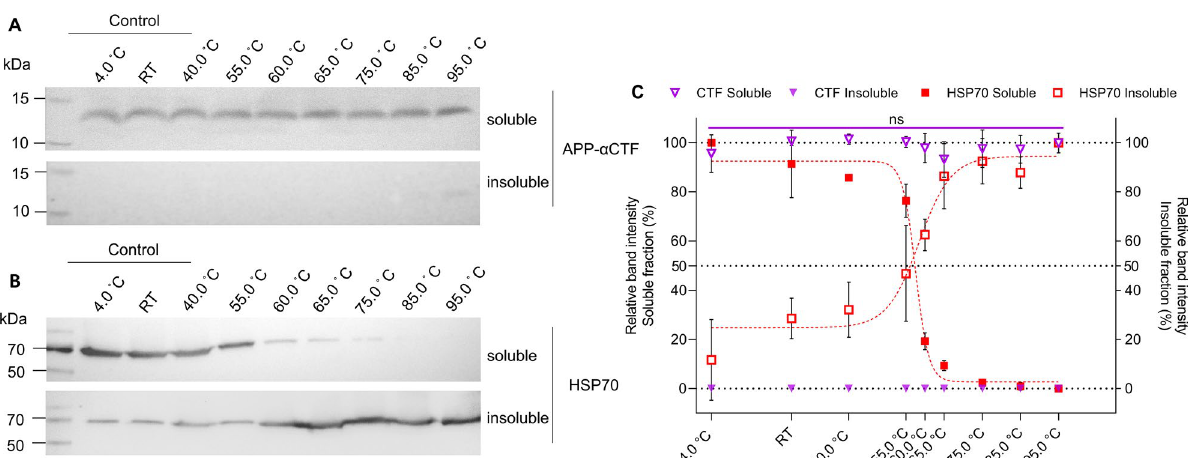
Figure 3. The detection of soluble and insoluble APP-αCTF and HSP70, including 4.0 °C and room temperature (RT) controls. ( A ) A representative cropped western blot of APP-αCTF in the soluble (open purple inverted triangle) and insoluble fraction (filled purple inverted triangle) from HEK293 cell lysate after temperature exposure (4 °C, RT, 40–95 °C) and ( B ) a representative western blot of HSP70 in the soluble (filled red square) and insoluble (open red square) fraction from HEK293 cell lysate after temperature exposure (4 °C, RT, 40–95 °C) with ( C ) the corresponding relative band intensity sigmoidal curves, for both soluble (left y-axis) and insoluble (right y-axis) protein, as mean ± SD calculated by setting the highest intensity for each data set as 100% and each curve generated using the Boltzmann sigmoidal equation (n = 3). Multiple paired t-test was performed for soluble APP-αCTF (purple line) where ns, not significant. See supplementary information file, raw data images for full-length western